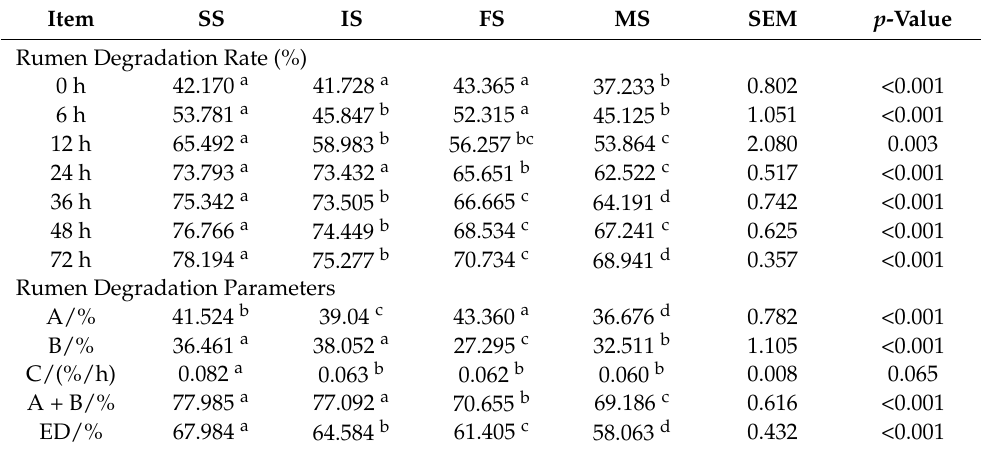
Table 3. Rumen DM degradation characteristics of Amaranthus hypochondriacus hay.